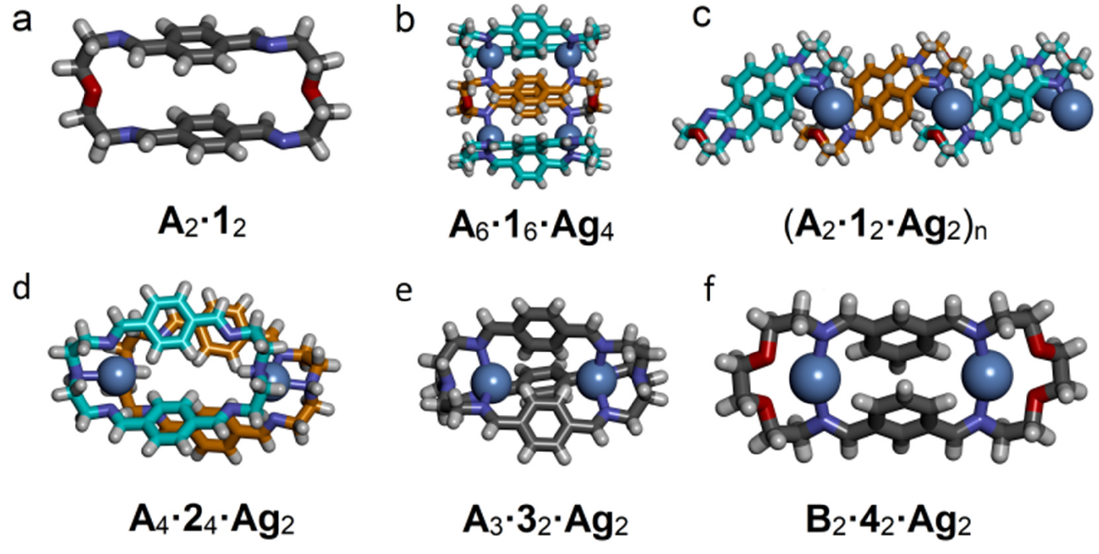
Figure 1. Crystal structures of macrocyclic ( a ) A 2 ·1 2 , metallosupramolecular macrocycles and cages ( b ) A 6 ·1 6 ·Ag 4 , ( c ) ( A 2 ·1 2 ·Ag 2 ) n , ( d ) A 4 ·2 4 ·Ag 2 , ( e ) A 3 ·3 2 ·Ag 2 , and ( f ) B 2 ·4 2 ·Ag 2 .